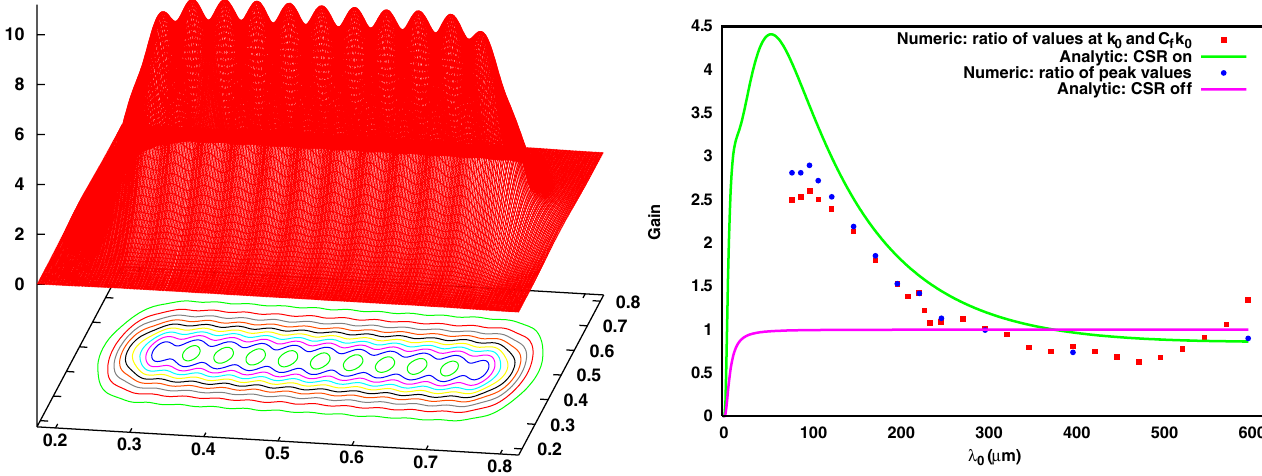
Þ 2 ½ 0 ; 1 (cid:2) (cid:7) ½ 0 ; 1 (cid:2) for an initial modulation (cid:2) ; x 1 2 Þ of the values of the Fourier spectra at k 0